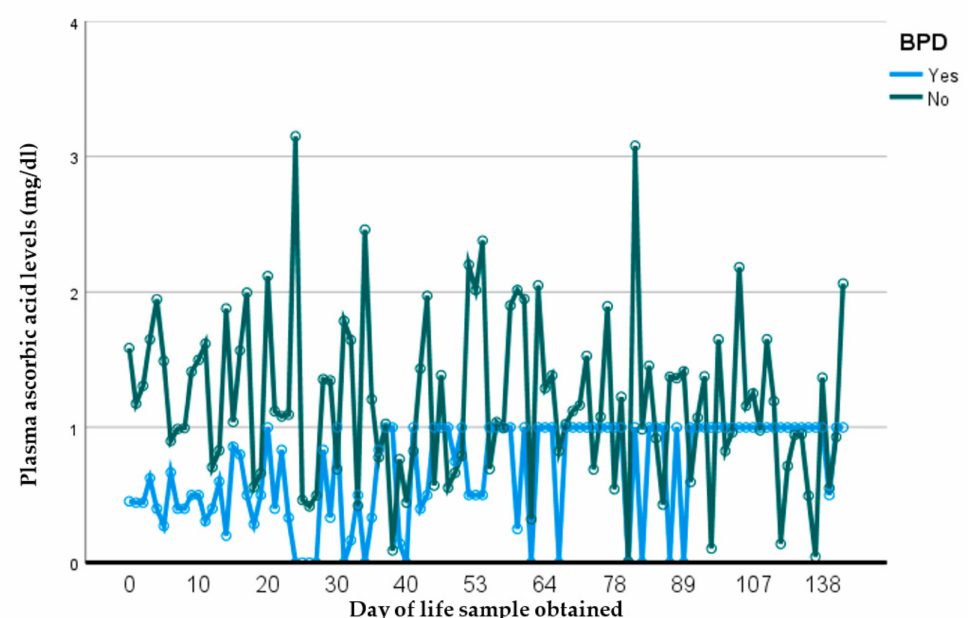
Figure 1. Measured plasma ascorbic-acid levels (mg/dL) per day of life in preterm infants ≤ 34 weeks with and without BPD. Infants who developed BPD had significantly lower pAscA levels at birth and these remained low throughout the study period compared to those who did not develop BPD ( p = 0.0003, 95% CI = − 0.36, 2.76). BPD = bronchopulmonary dysplasia, pAscA = plasma ascorbic acid. Table 7. Plasma ascorbic-acid levels and risk for morbidities in ≤ 30 weeks premature infants. N = 47 Mean pAscA (mg/dL) 95% Confidence Interval BPD Yes vs.